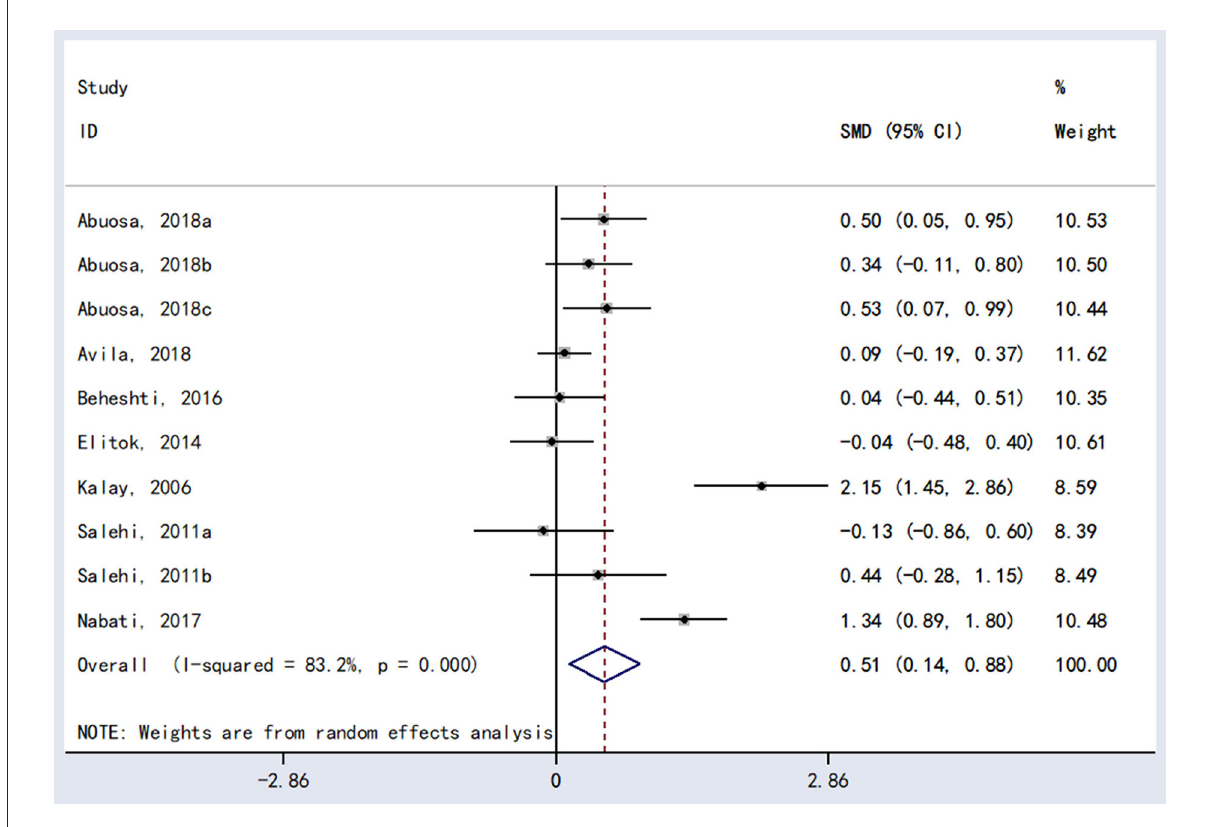
FIGURE3 The forest plot of the effect of carvedilol on